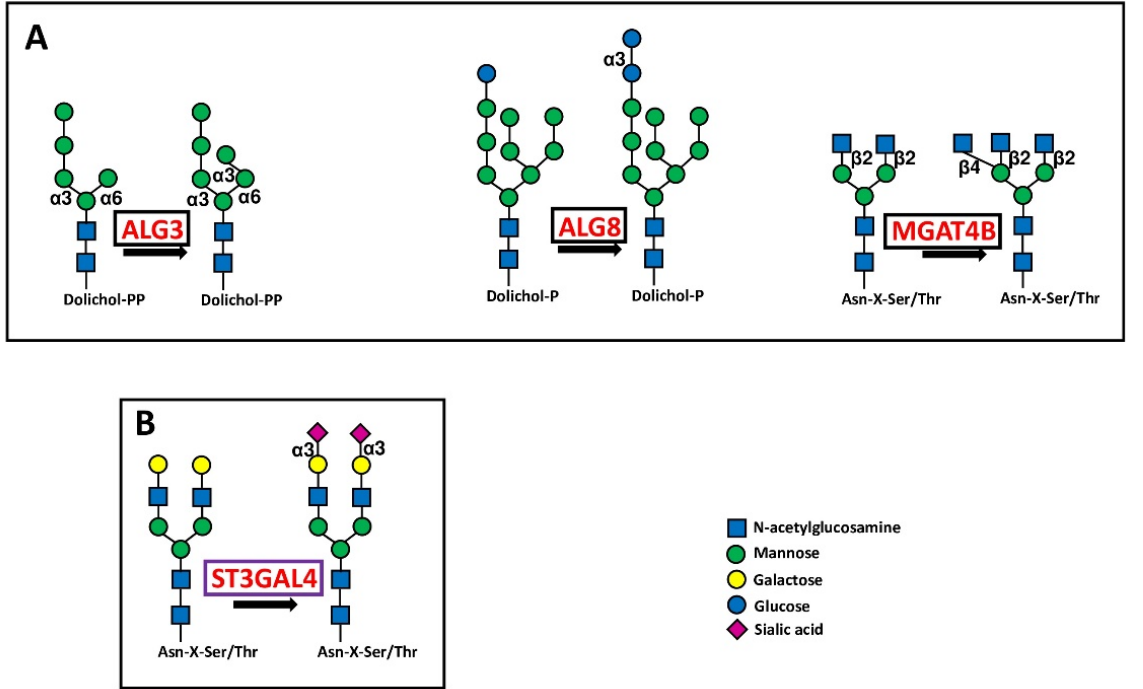
Figure 3. Biosynthetic steps in N-glycosylation. ( A ) shows the core glycosylation steps catalyzed by three BPA glycosyltransferases in initiation of N-glycosylation. ( B ) shows the reaction catalyzed by the chain capping sialyltransferase ST3GAL4 in N-glycan biosynthesis. Enzymes catalyzing core glycosylation are boxed in black, while that catalyzing chain capping is boxed in